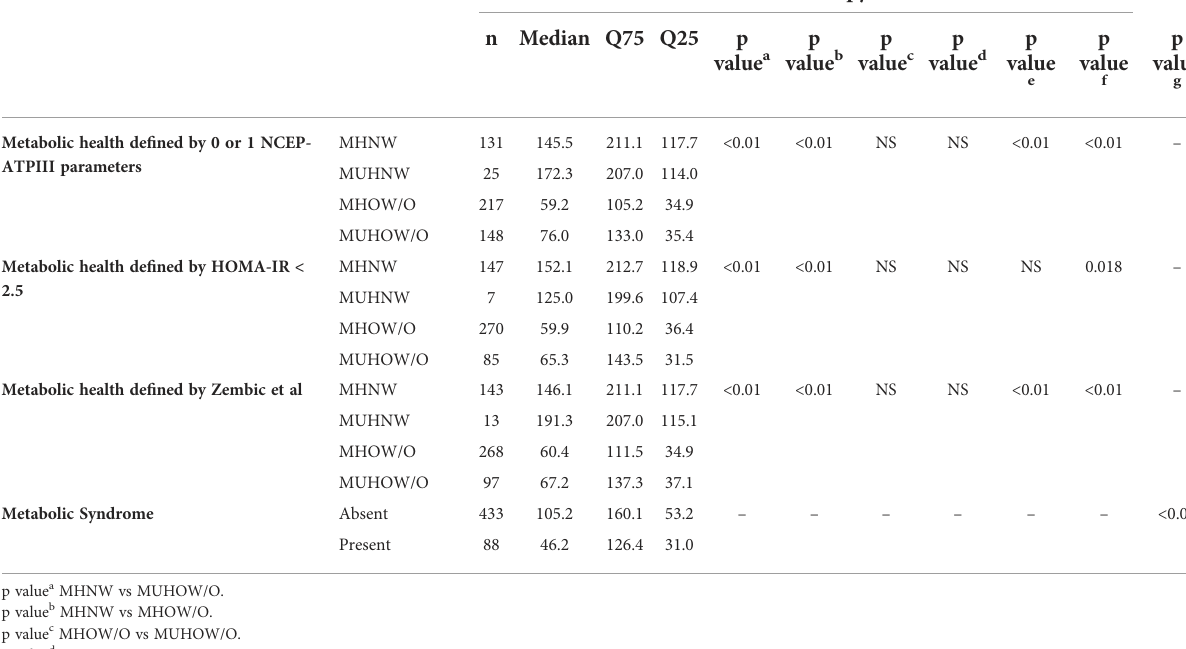
TABLE 2 Relative mtDNA copy number across de fi nitions of metabolic health based on 0 or 1 NCEP-ATPIII criteria, HOMA-IR < 2.5, the empirical de fi nition by Zempic et al. and the metabolic syndrome. Metabolic health de fi nition